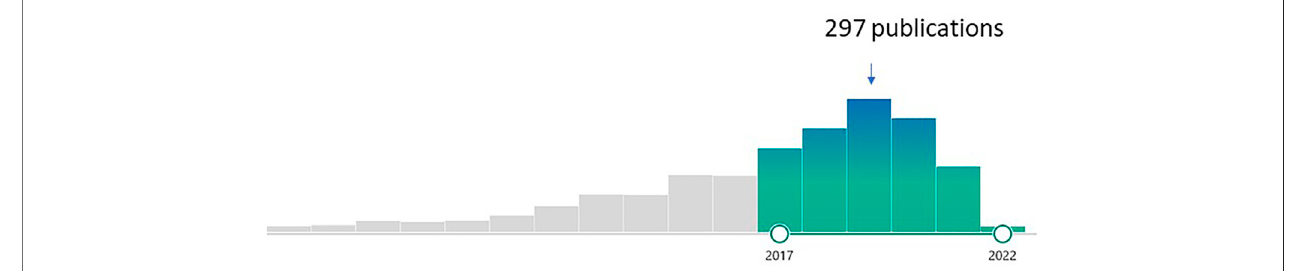
FIGURE 1 | Trend of research on “ Non-coding RNA and Wnt/ β -Catenin Signaling Pathway in Human Cancer. ” Green bars-highlighting the last 5 years ’ publications (Source: